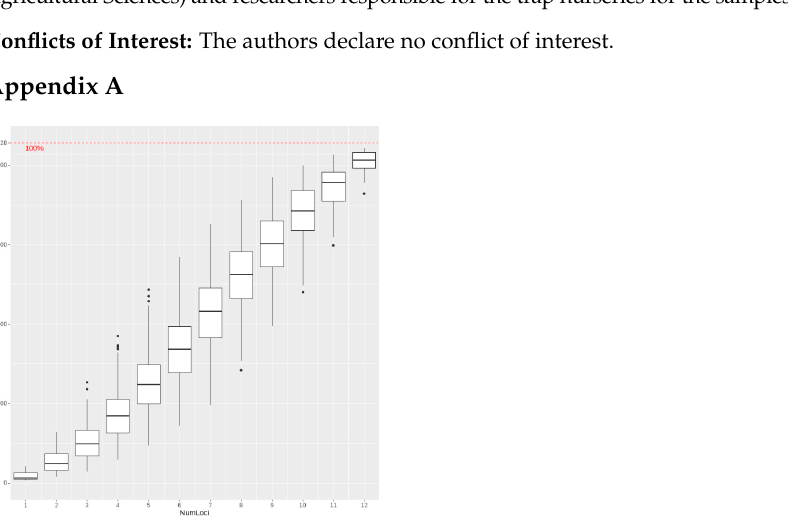
Figure A1. Genotype accumulation curve is a tool that allows us to assess if it is sufficient to discriminate between unique individuals for given a random sample of the loci. It had reached the plateau with 12 loci indicating that the 13 loci we used is enough for distinguishing all the observed MLG s. Table A1. Information of the samples of Pt collected from different areas in 2018.